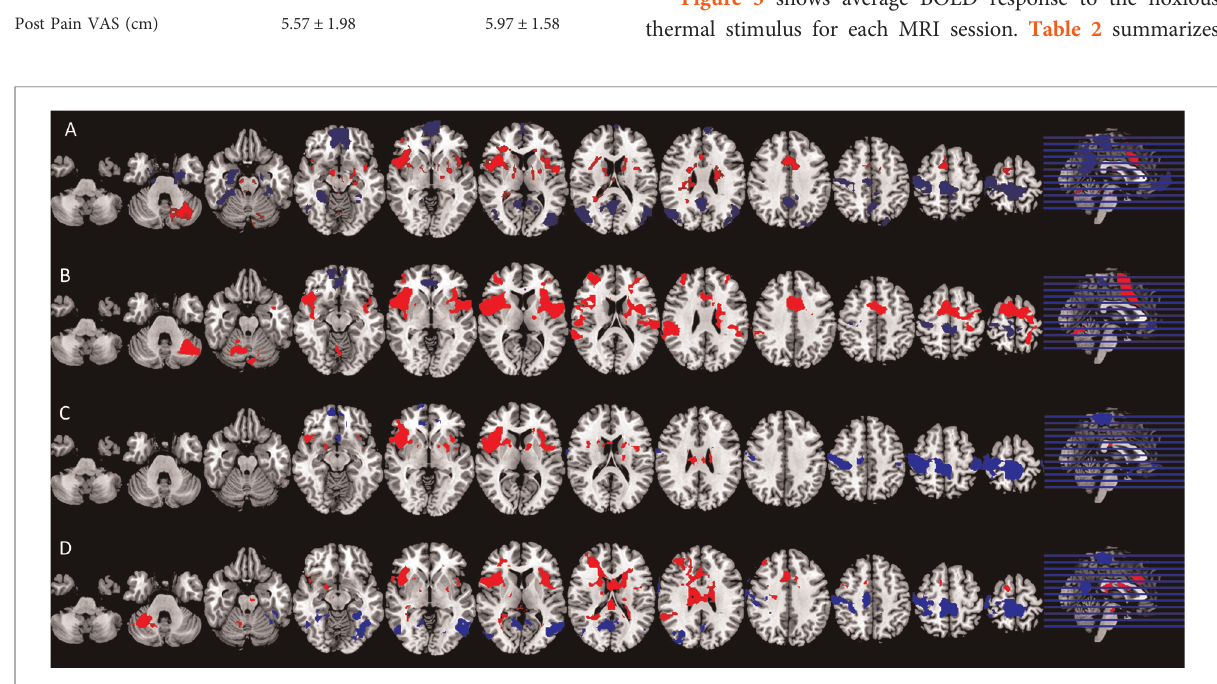
FIGURE 3 Signi fi cantneuralresponsestothermalnoxiousstimuli,resultingfromawhole-brainanalysisof( A )thecontrolcondition fi rstscan(pre)and( B )thecontrol conditionsecondscan(post)( C )thespinalsession fi rstscan(pre)and( D )spinalsessionsecondscan(post).Signi fi cantlyactivatedvoxelsareshowninred, signi fi cantly deactivated voxels in blue, p <0.05 cluster corrected. Images are Z-statistics thresholded at (-)2.3, overlaid on the MNI-152 standard brain. Slices are displayed in radiological convention (left=right). All signi fi cant clusters are described in detail in Appendix Tables 1a , 1b , 2a , 2b